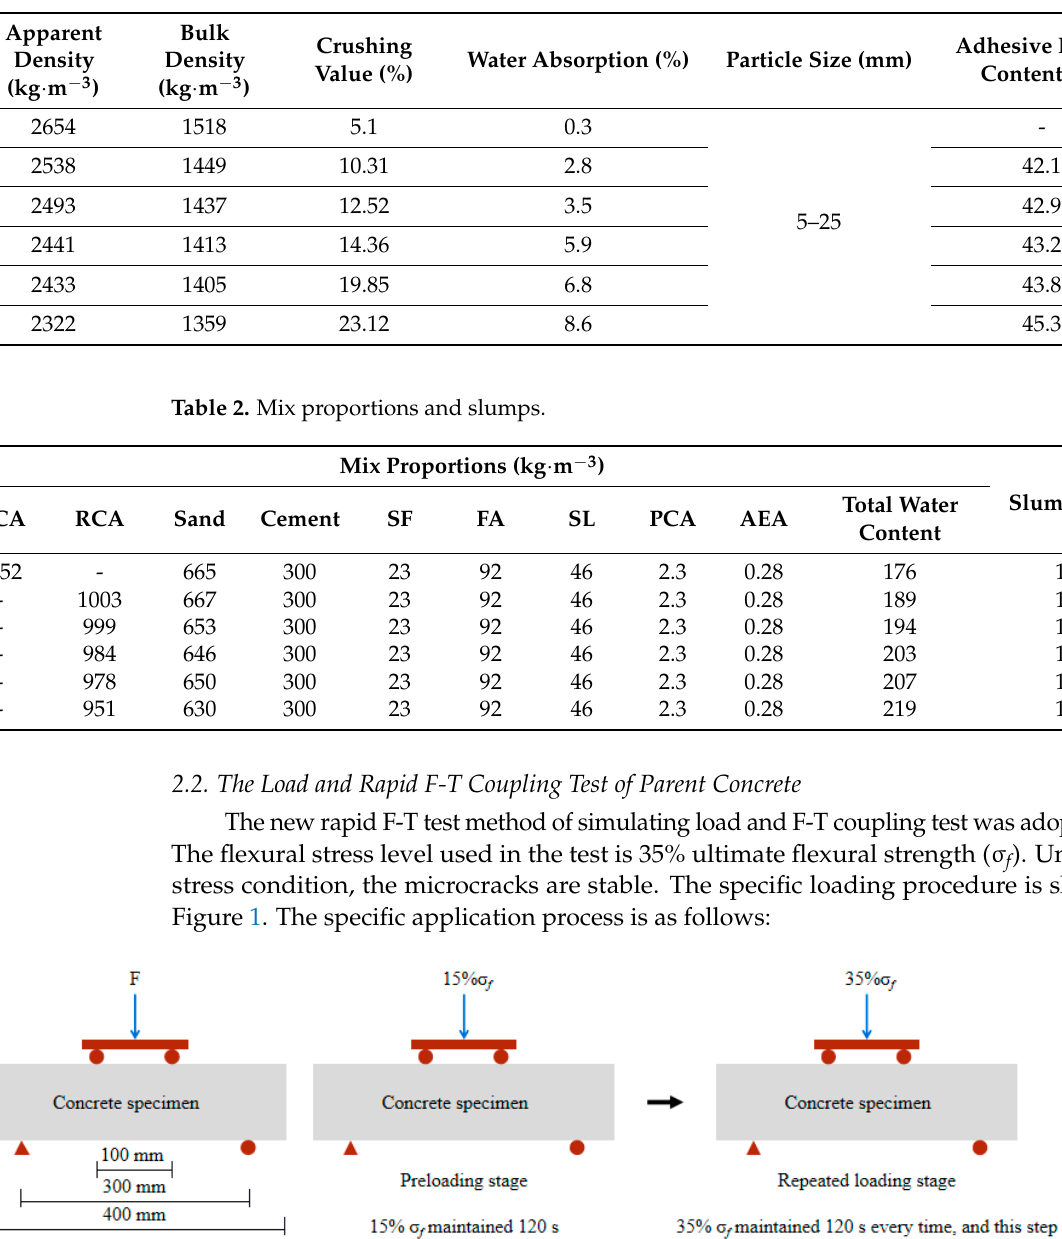
Figure 1. Loading procedure diagram.